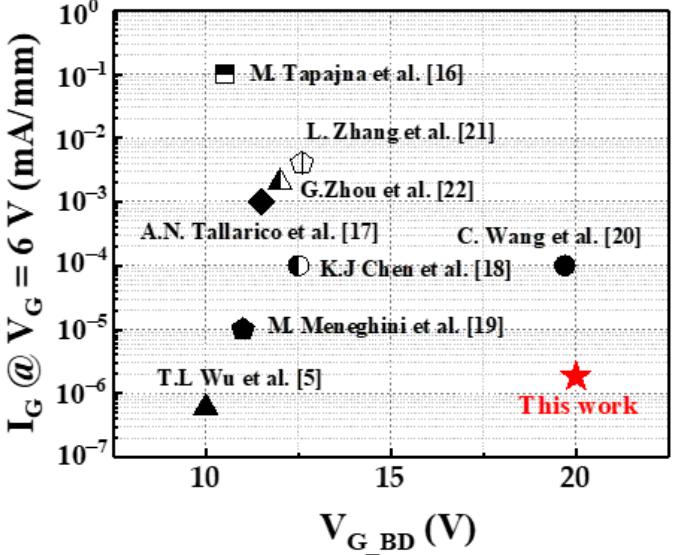
Figure 7. Comparison between the V G_BD – I G characteristics of the proposed device and those of other devices [5,16 – 22].